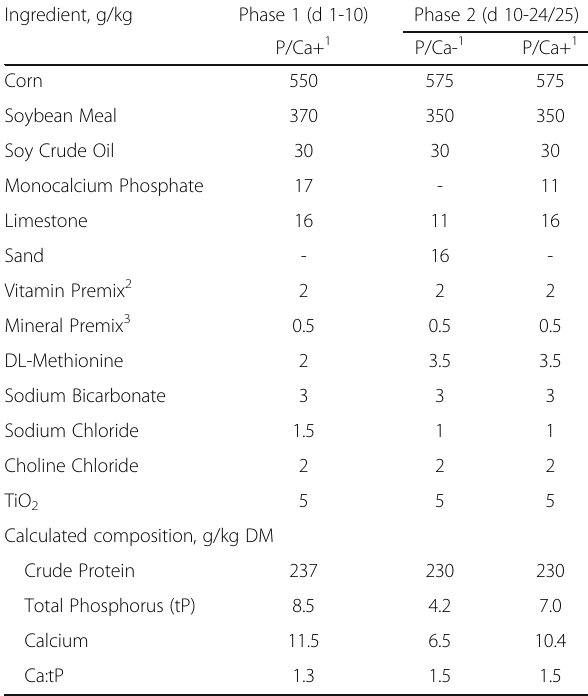
Table 4 Ingredient composition of the diets and calculated